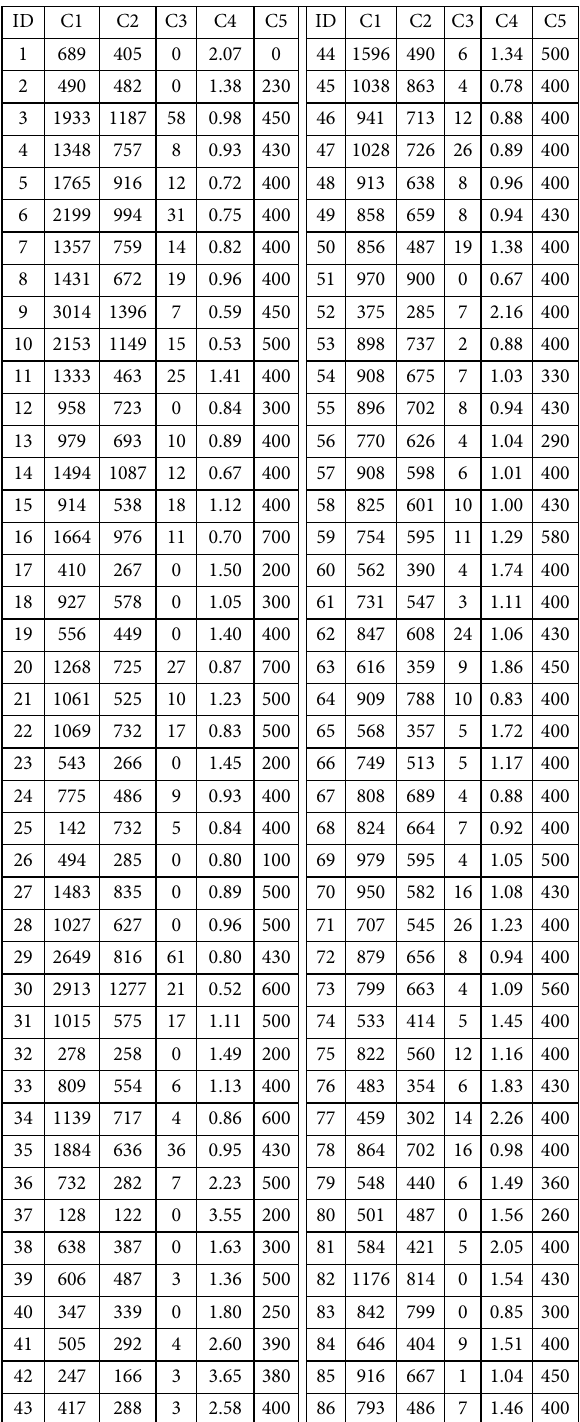
Table 3. Decision matrix constructed from the in-game data representing the behaviour of the GBS